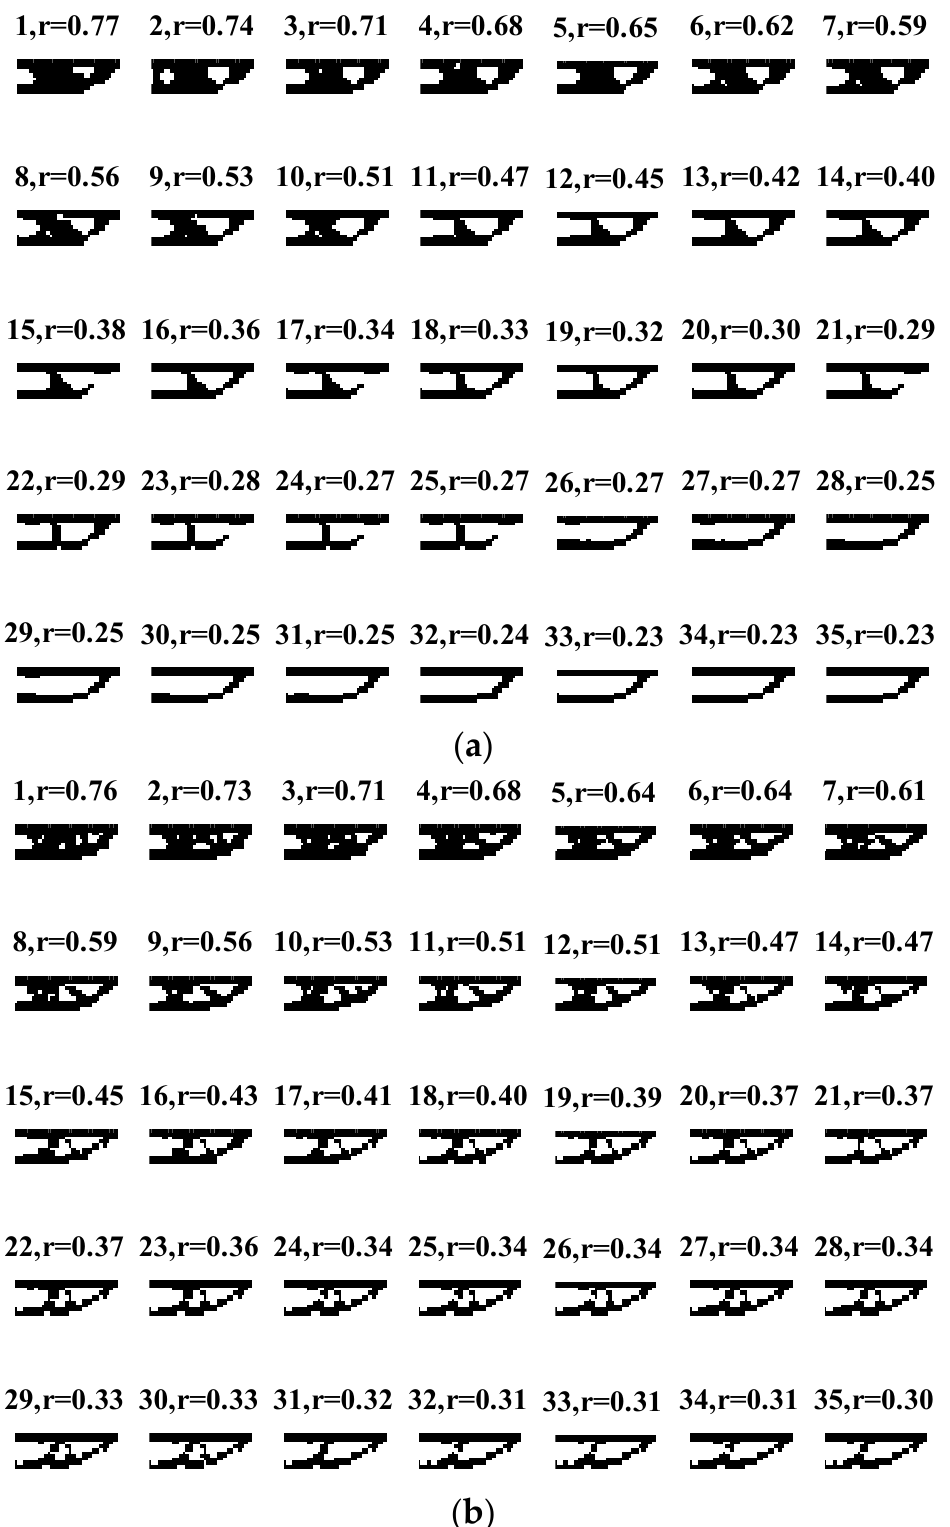
Figure 6. Topologies of MOP3: ( a ) OMPBIL with multi-grid; and ( b ) MPBIL without multi-grid.